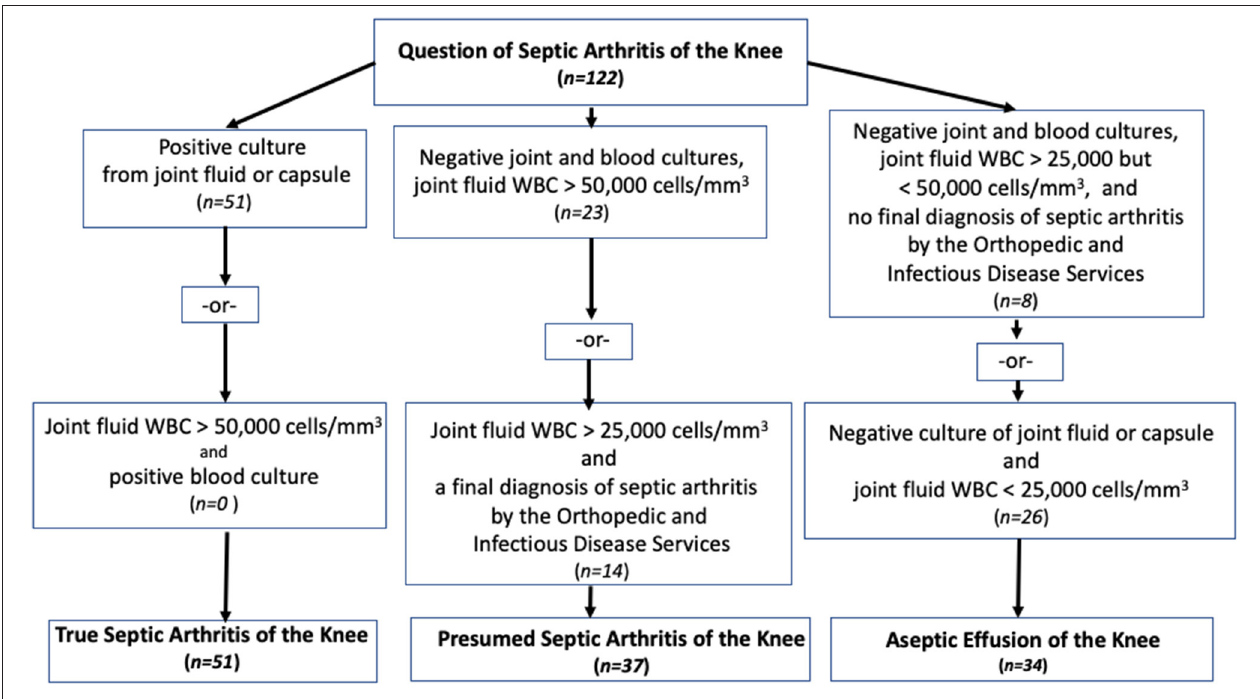
FIGURE 1 | Algorithm for determining the patient groups.